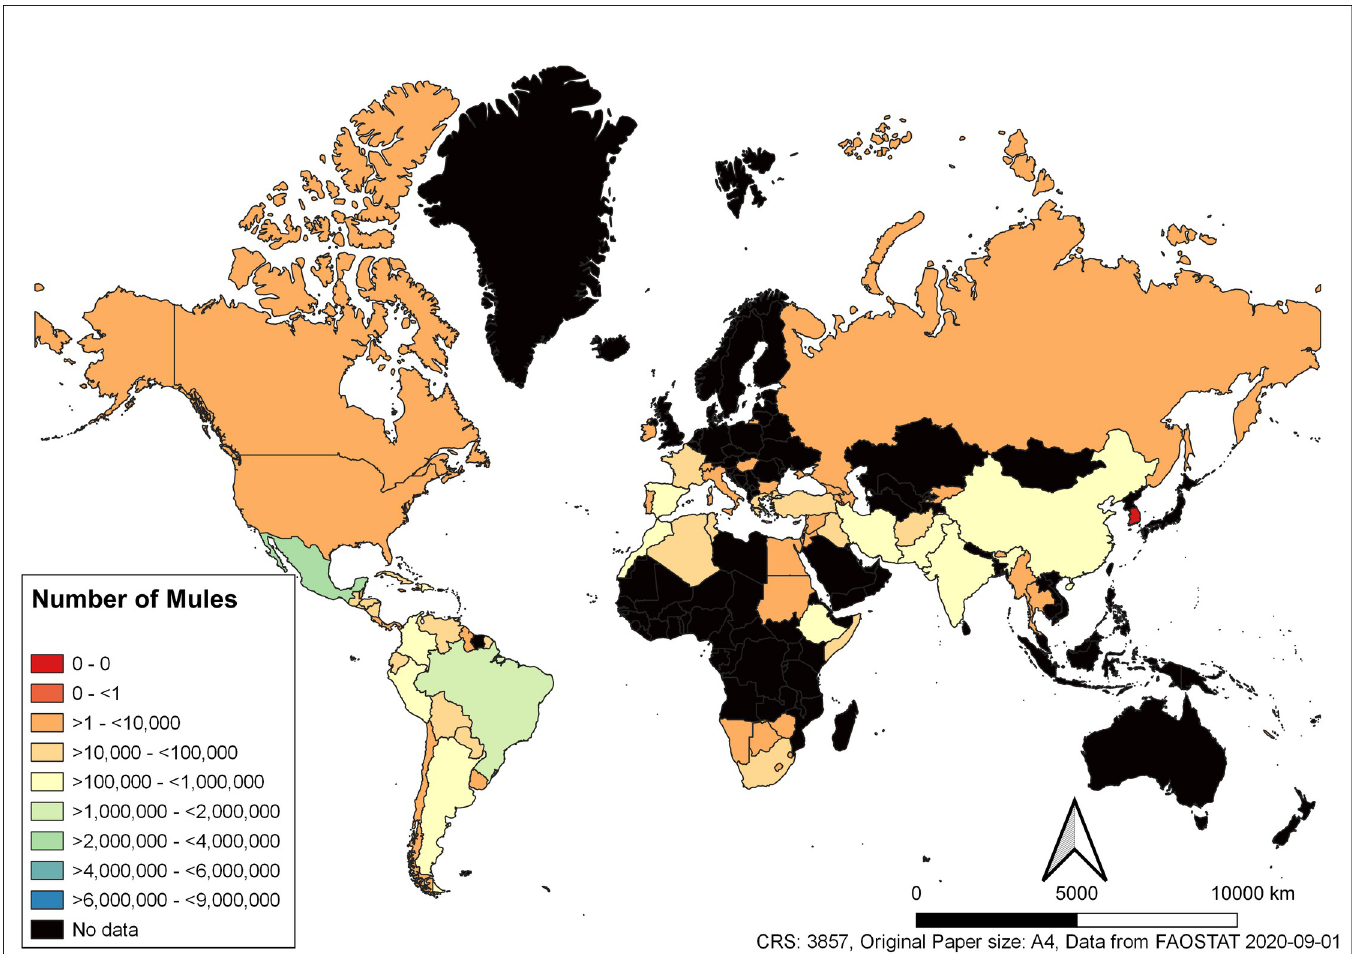
Fig 3. Global mule population sizes for each country in 2018. Data from FAOSTAT, where data has not been made available to FAOSTAT countries are shaded black.